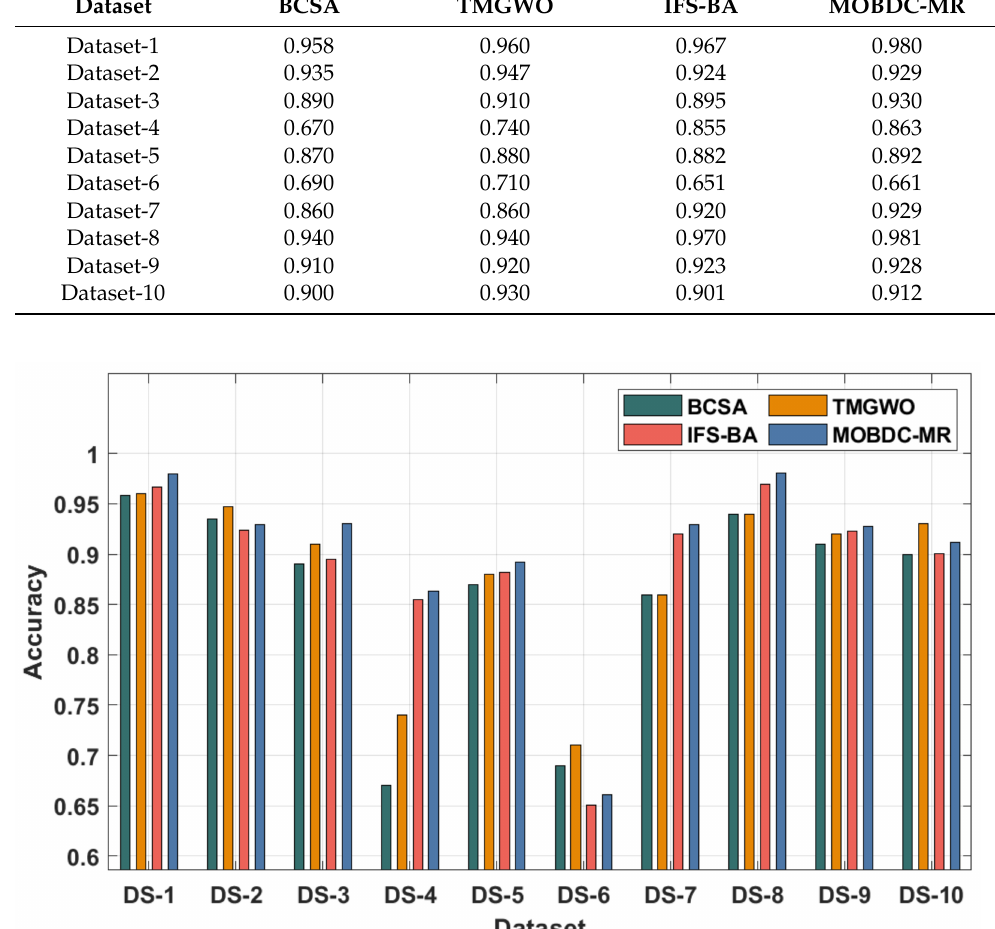
Figure 7. Overall accuracy analysis of the MOBDC-MR